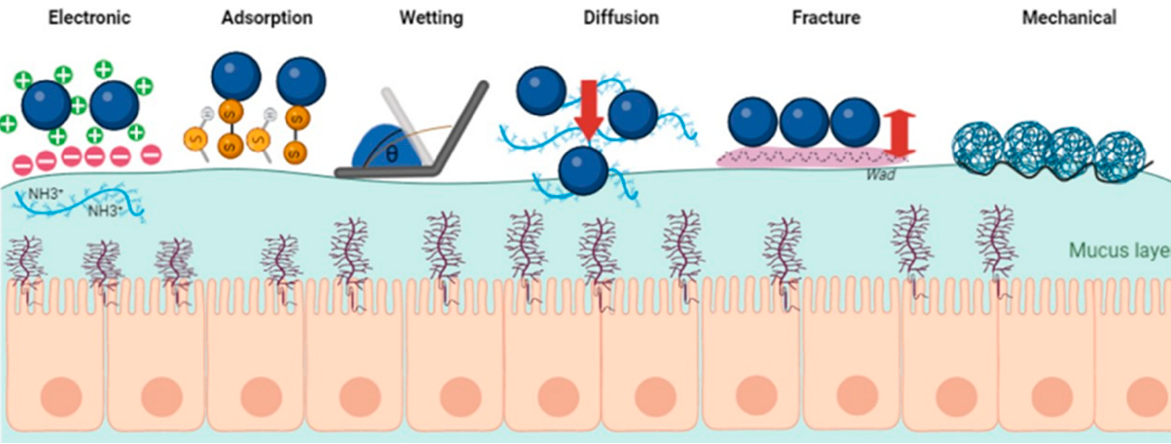
Figure 3. Theories of mucoadhesion. The electronic theory describes mucoadhesion mediated by electrostatic forces. Adsorption assumes intermolecular contact at the interface and adhesion of materials by intermolecular forces. Wetting is described in terms of the spreading coefficient; therefore, the requirement for mucoadhesive materials to adhere is that these can spread spontaneously onto a surface. The diffusion theory: interdiffusion and interpenetration through the polymer-mucin interface according to their concentration gradient. Fracture describes the forces required to separate two surfaces after bonding and assumes that adhesion bond failure occurs at the interface ( Wad : work adhesion). Mechanical assumes that the irregular rough or abrasive substrate surface provides mechanical keying.